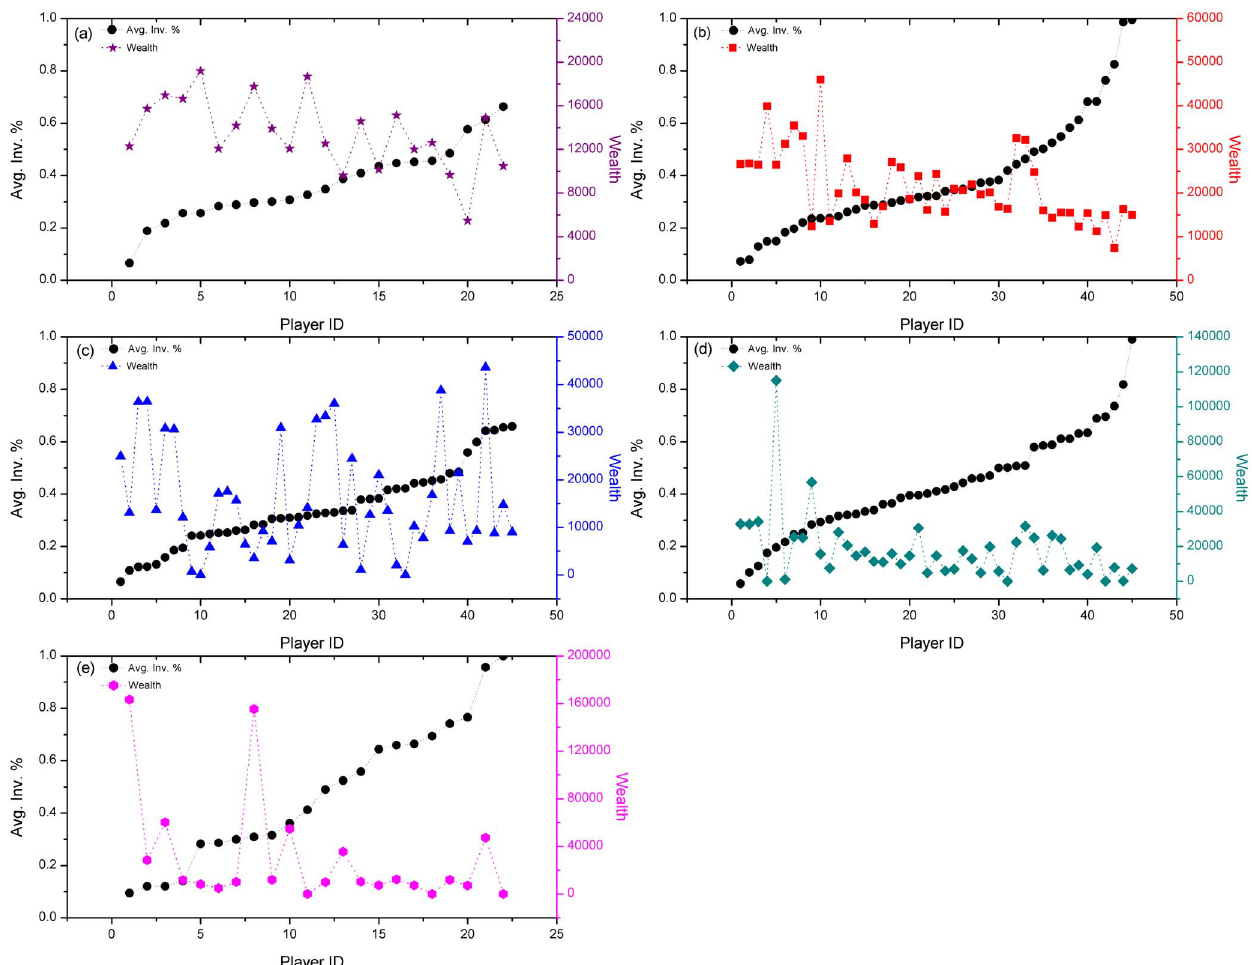
Figure 6. The players’ risk preference and wealth in each experiment. Black dots are the average investment proportion of each player in a certain experiment; colorful dots represent the final wealth of the player. In order to see the relation between risk preference and final wealth, Player IDs in each experiment are realigned in the order of a growing investment proportion.